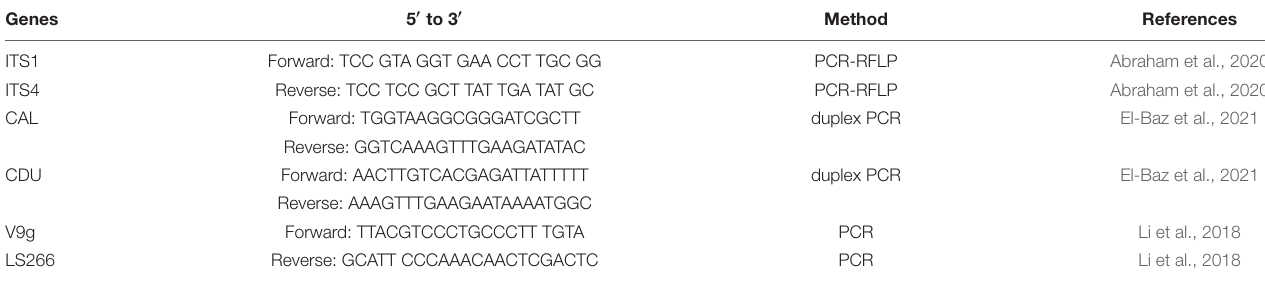
TABLE 1 | Primers for PCR-RFLP, sequencing, and duplex PCR. Genes 5 (cid:48) to 3